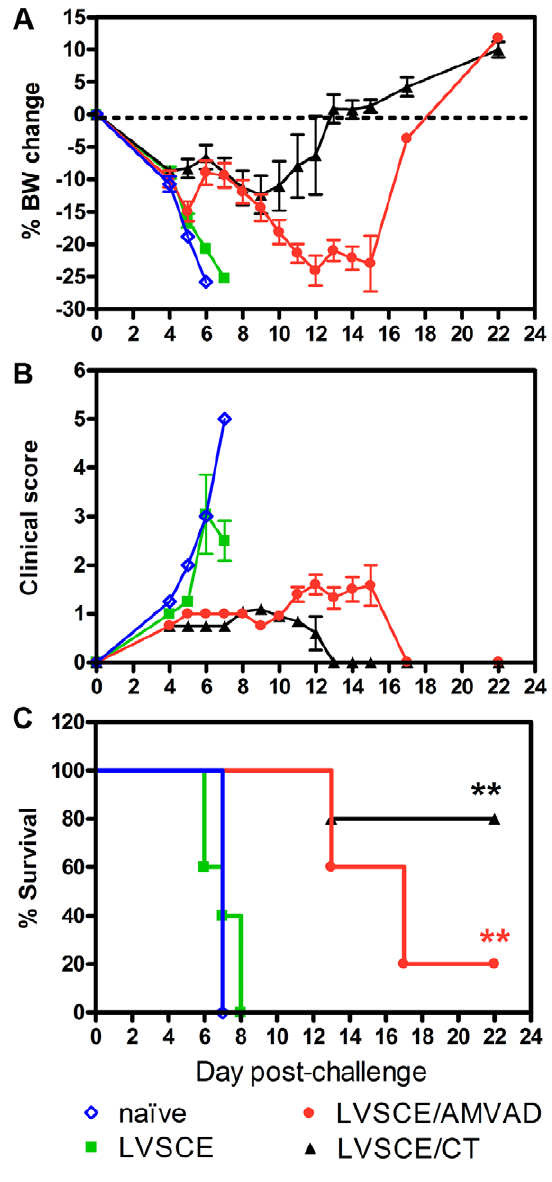
Figure 4. LVSCE/AMVAD vaccine partially protects against i.n. F.tularensis LVS challenge. The remaining naı¨ve, and LVSCE, LVSCE/ AMVAD or LVSCE/CT immunized groups of mice (n=15) in Figure 1 experiment, were intranasally challenged with F. tularensis LVS (3.4 6 10 4 cfu) at 35 d (14 d post the last immunization). The % change in body weight (A), clinical scores (B) and % survival (C) of sub-groups of 5 mice per each group was recorded over a 22 d period subsequent to the challenge. The data are presented as mean 6 SD for each group (n=5) for panels A and B. ** p , 0.01 vs. LVSCE alone immunized group. Data are representative of two separate